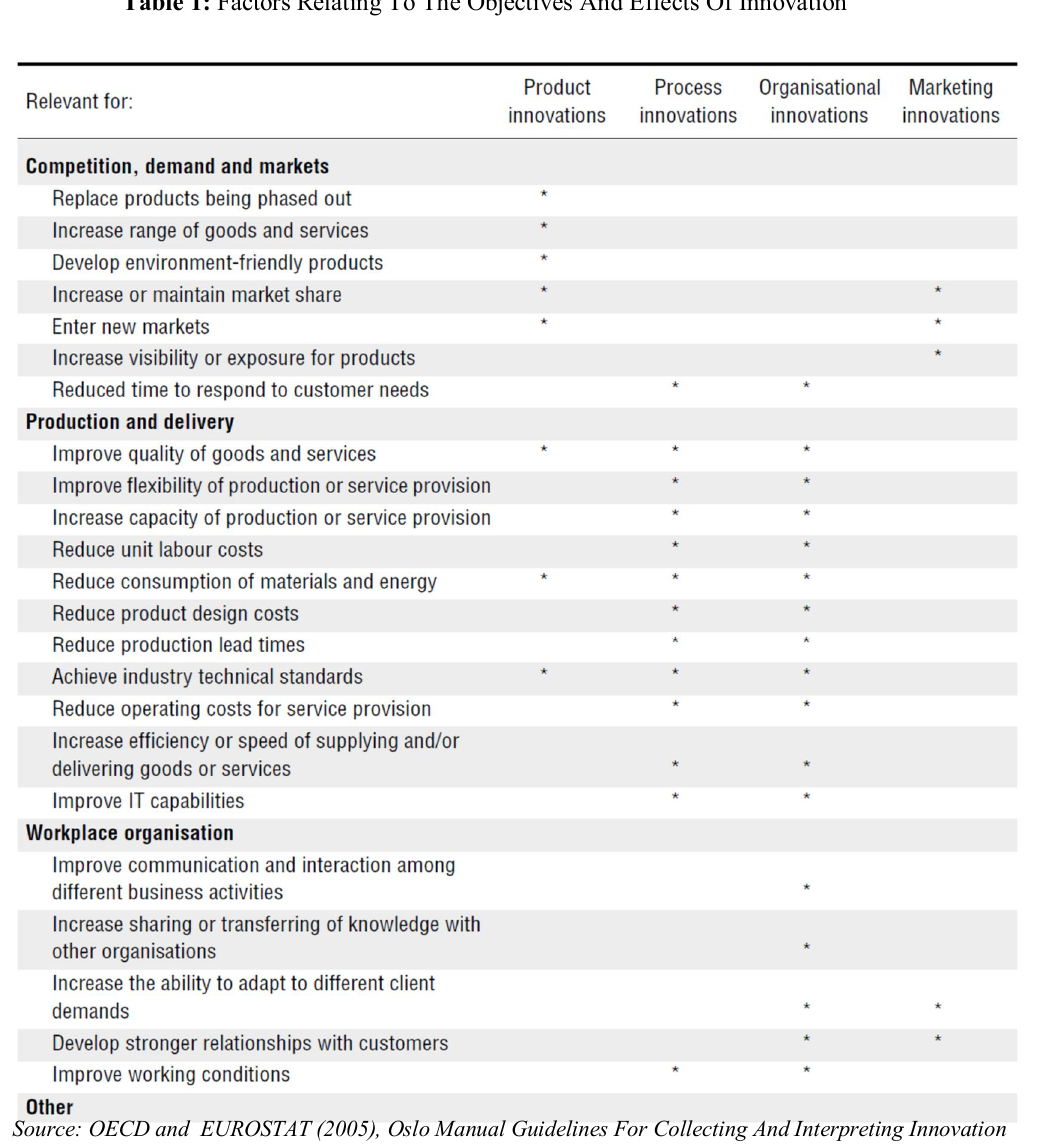
Table 1: Factors Relating To The Objectives And Effects Of